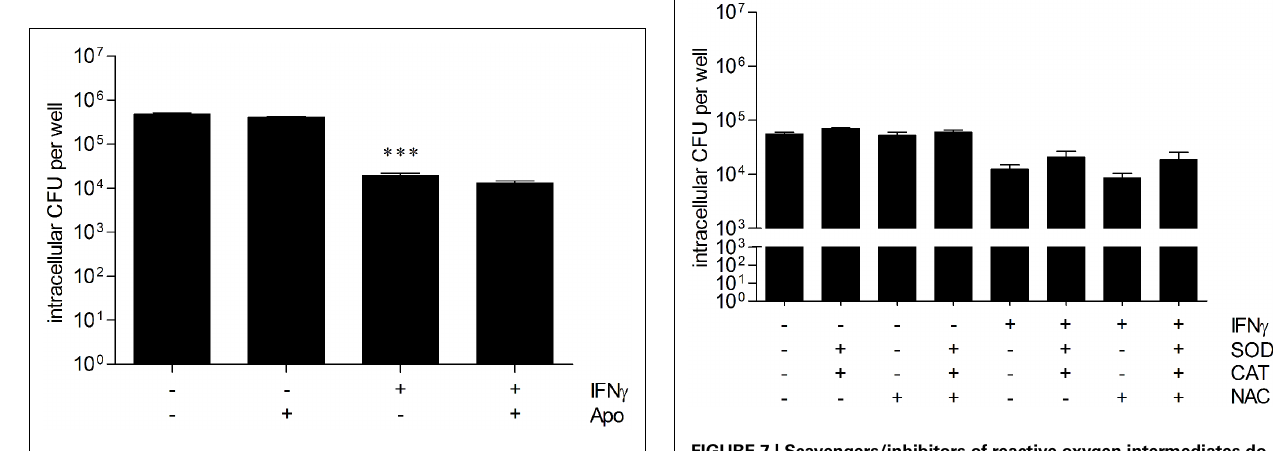
FIGURE 6 | NADPH oxidase is not important for the control of B. pseudomallei hepatocyte infection. Intracellular survival of B. pseudomallei E8 24h after infection (MOI 31:1) of resting and IFN γ -activated (500ng/ml) HepG2 cells in the presence of NADPH oxidase inhibitor apocynin (Apo, 500 μ M). Data are presented as mean with SEM of triplicate determinations. One representative experiment out of three independent experiments is shown. Statistical analyses were performed using a Student’s t -test (*** p < 0.001).